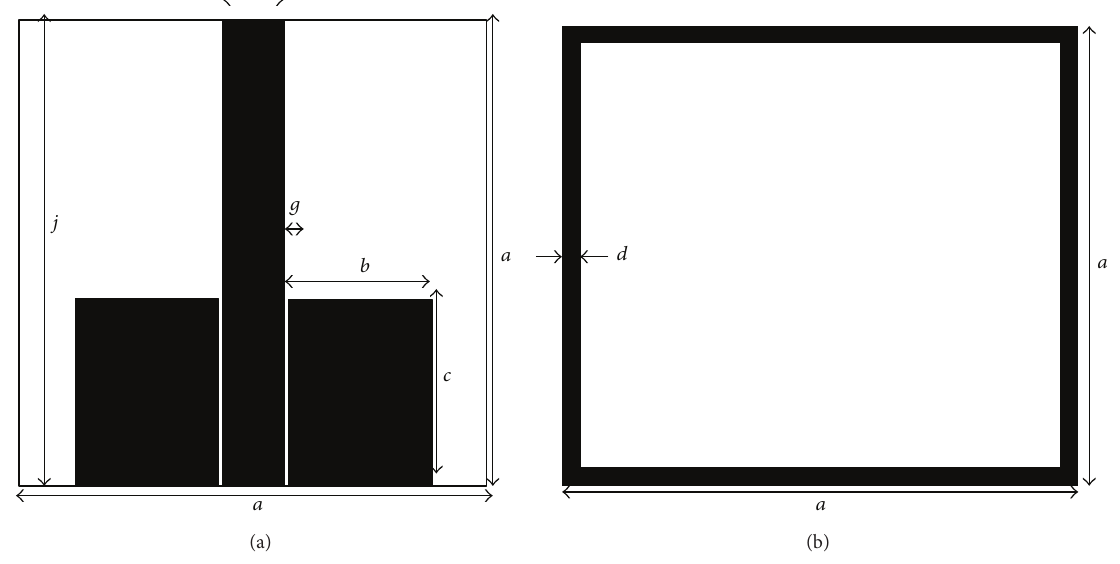
Figure 2: Proposed dimension of the antenna (a) patch and (b) ground plane.